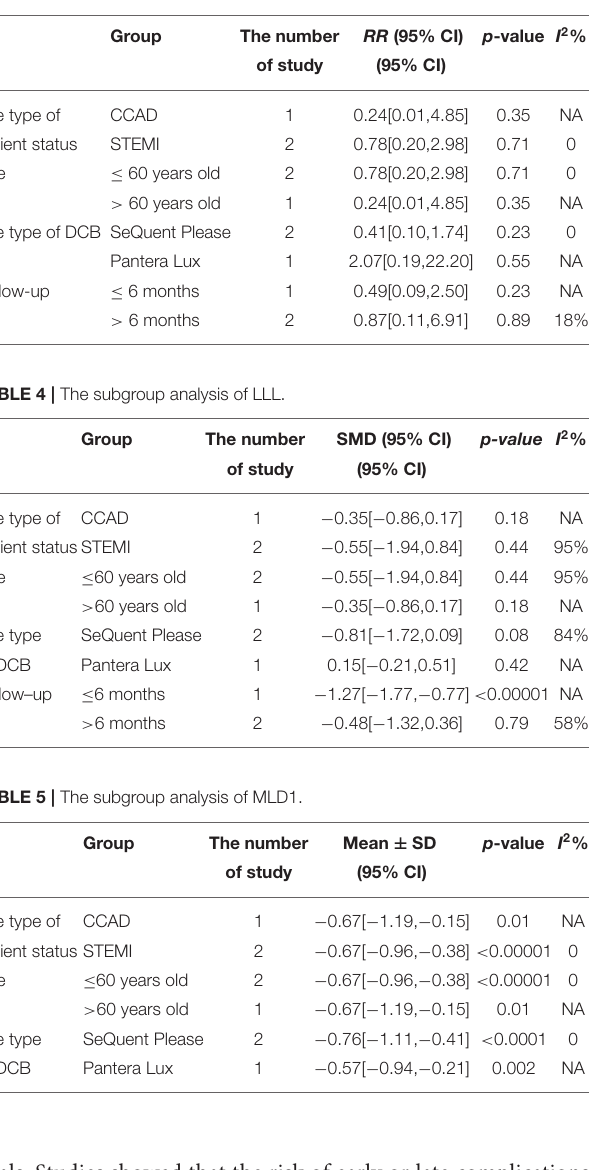
TABLE 6 | The subgroup analysis of